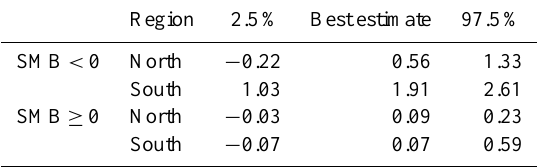
Table 1. The 2.5% quantile, best estimate, and 97.5% quantile estimates of the SMB–elevation gradients in kgm − 3 a − 1 , below (SMB < 0) and above (SMB ≥ 0) the ELA, for regions north and south of 77 ◦ N.